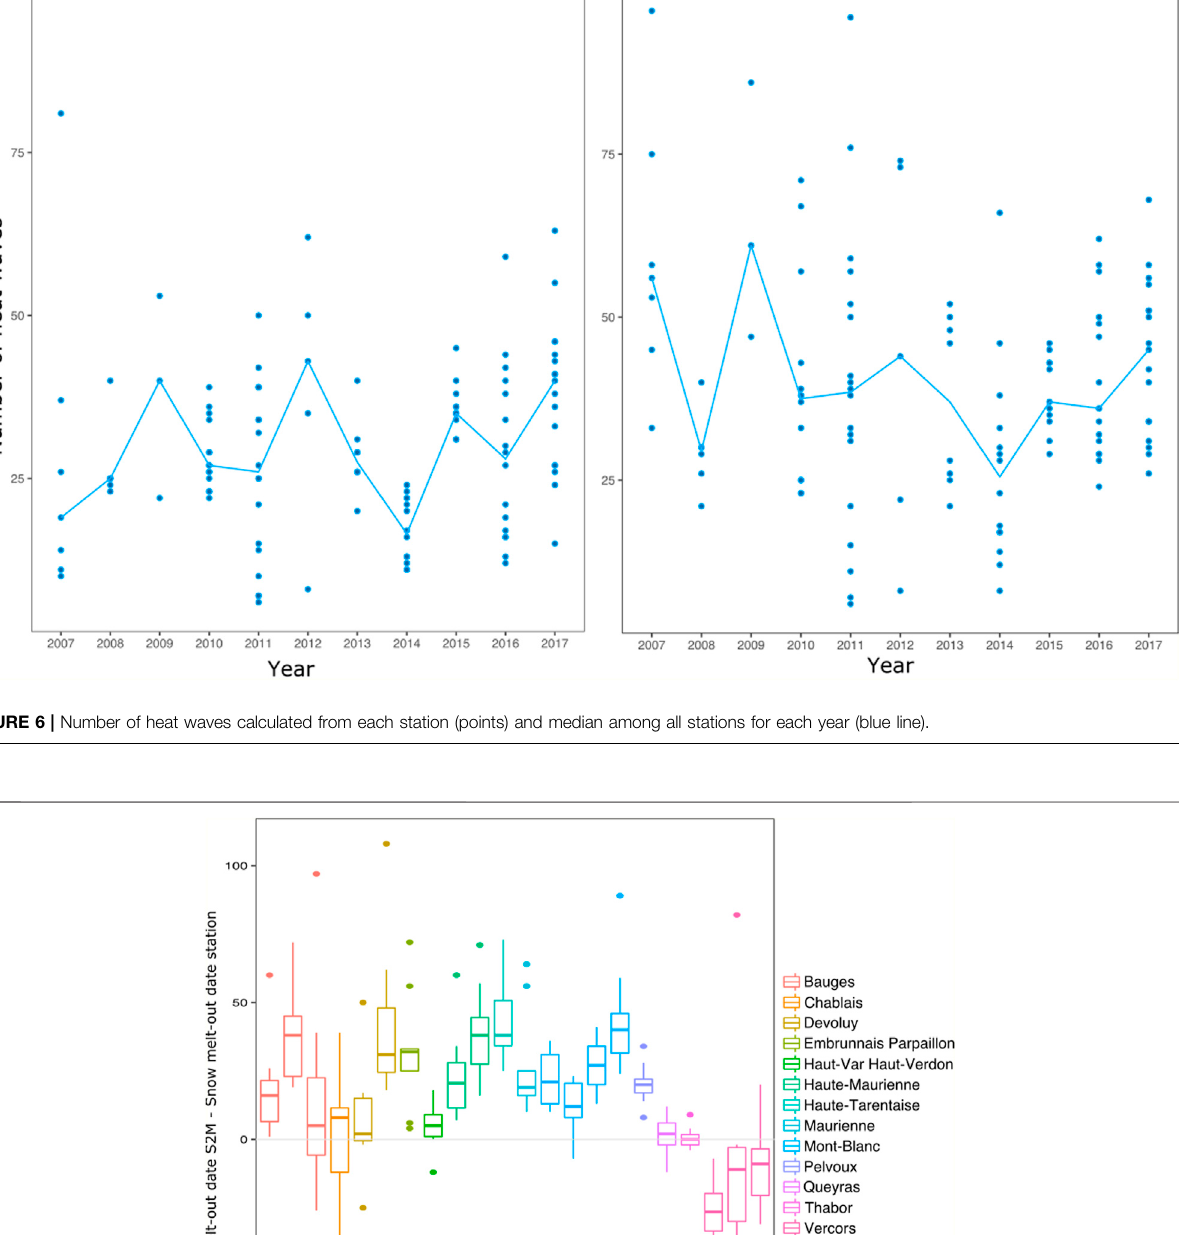
Frontiers in Earth Science |